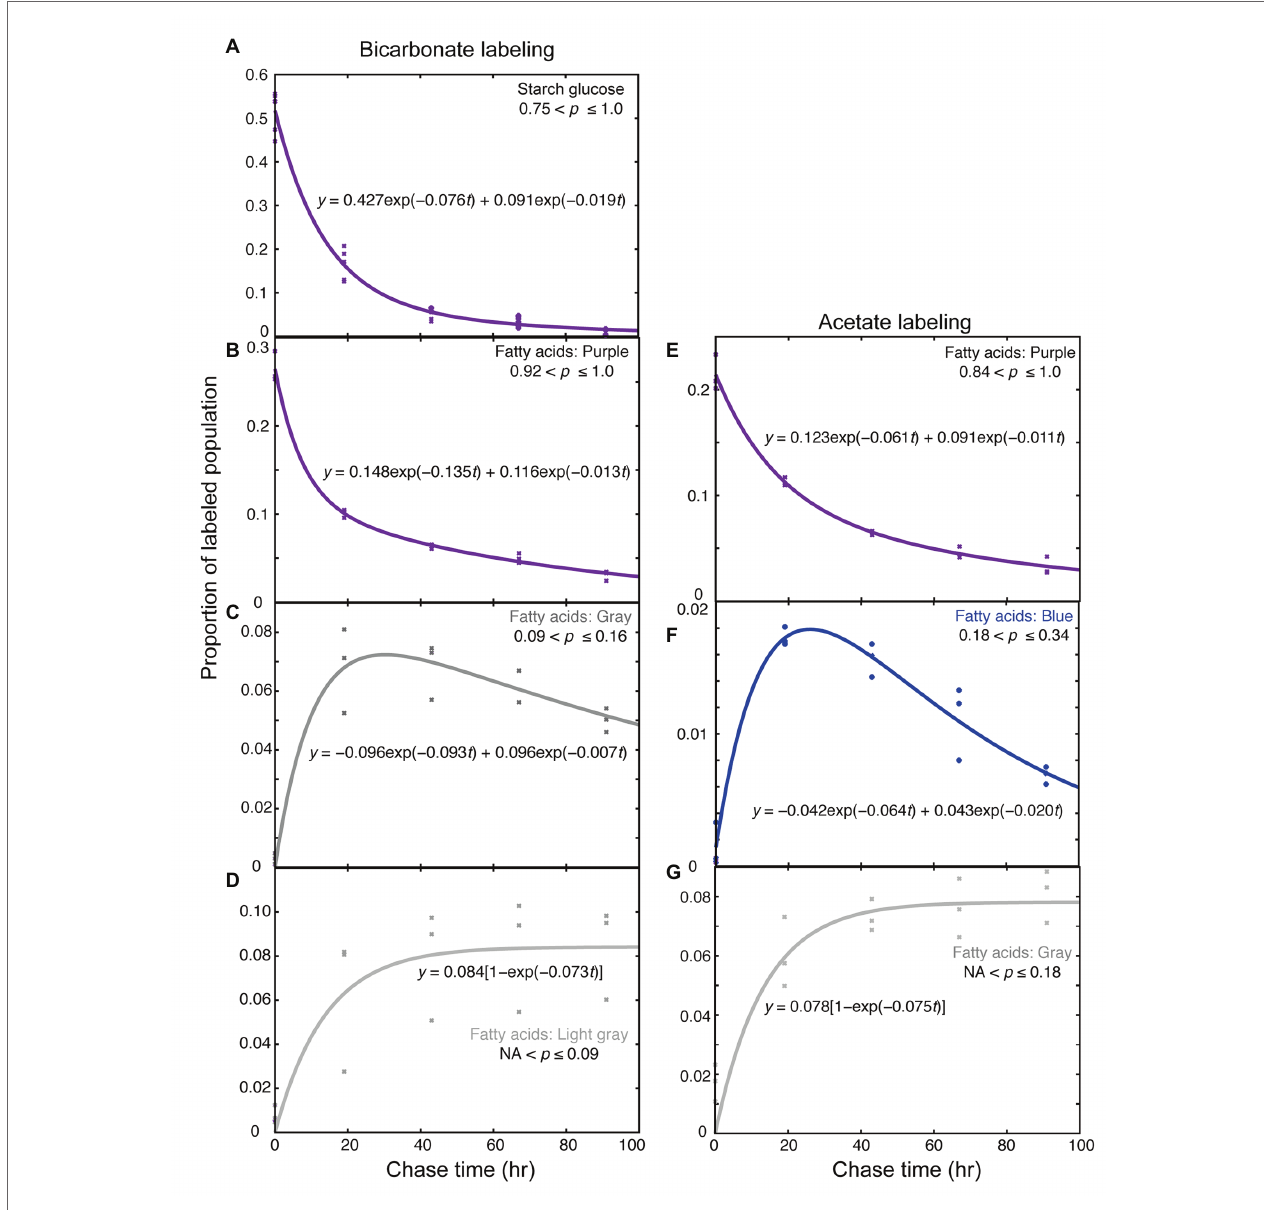
FIGURE 6 | Kinetic analysis of labeled populations during the chase. (A–D) Labeling with [ 13 C]bicarbonate. (E–G) Labeling with [2- 13 C]acetate. (A) Starch glucose; (B–E) Highly labeled fatty acids; (C) Low- p (gray population) fatty acids; (D) Very low- p (light gray population) fatty acids; (F) Mid-low- p (blue population) fatty acids; and (G) Low- p (gray population) fatty acids. Kinetic analysis was performed with the R software according to Supplementary Material